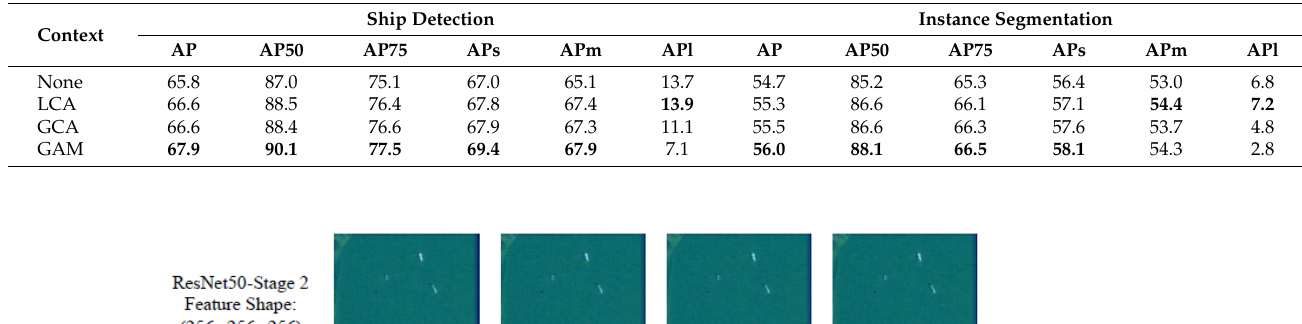
Table 4. Ablation experiment of context attention in a different scale of GAM.